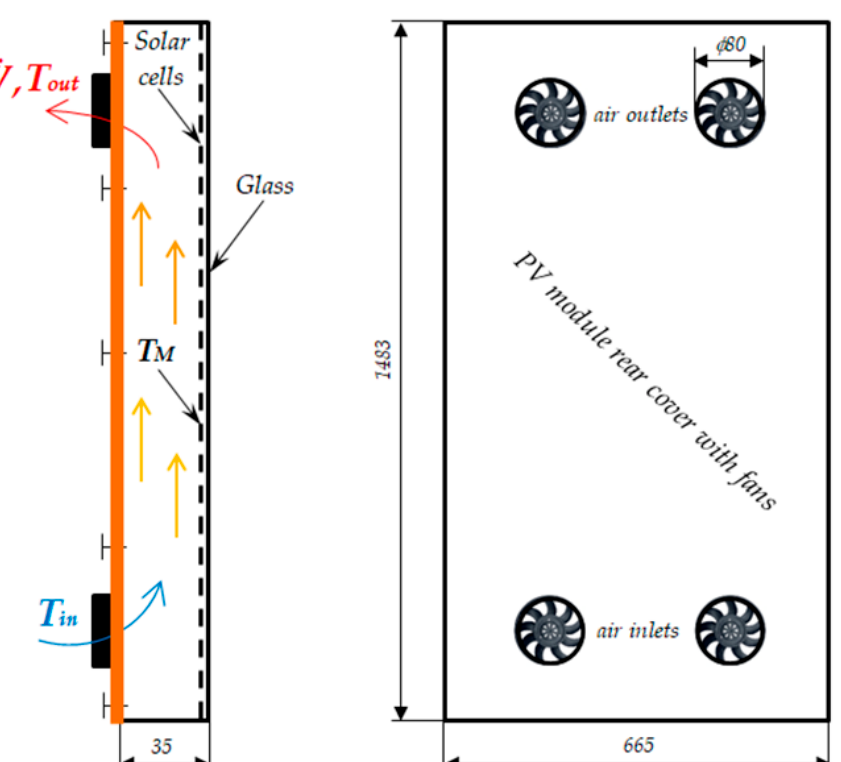
Figure 1. Schematic diagram of the modified PV module with built-up space: T in —inlet air temperature; T out —outlet air temperature; T M —PV module temperature; 𝑉(cid:4662) —the volumetric flow rate of air.